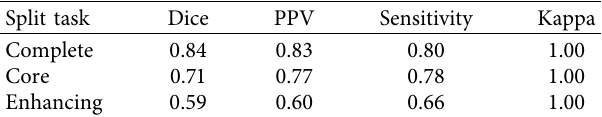
Figure 6: The average correct rate of 200 patients in the training data set with segmentation. Table 4: The average correct rate with the segmentation of 100 patients in the tested data